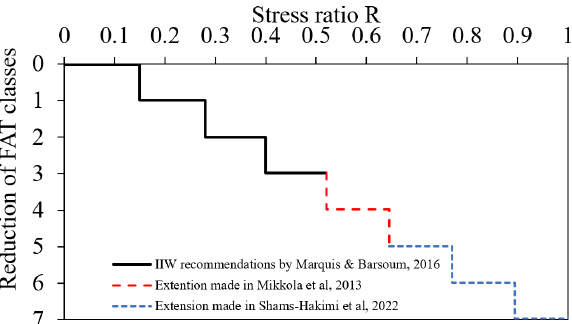
Figure 1. Proposed reduction in fatigue strength class depending on the stress